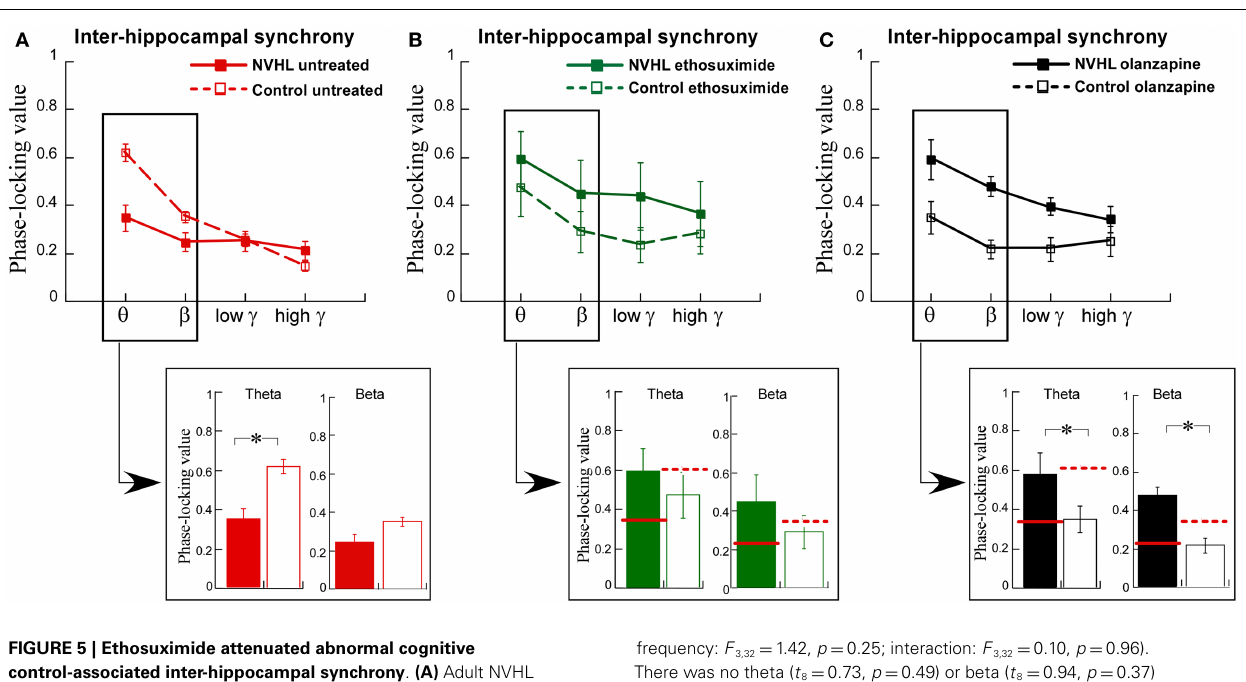
FIGURE 5 | Ethosuximide attenuated abnormal cognitive control-associated inter-hippocampal synchrony . (A) Adult NVHL rats had lower inter-hippocampal synchrony compared to control rats (two-way ANOVA group: F 1,32 = 8.87, p = 0.006; frequency: F 3,32 = 23.6, p < 0.0001; interaction: F 3,32 = 7.68, p = 0.0005). Inter-hippocampal theta ( t 8 = 3.98, p = 0.004) and beta ( t 8 = 2.30, p = 0.05) synchrony was weaker in the NVHL rats compared to the controls. (B) Ethosuximide treatment attenuated the inter-hippocampal synchrony difference between the NVHL and control rats (two-way ANOVA group: F 1,32 = 3.05, p = 0.09;